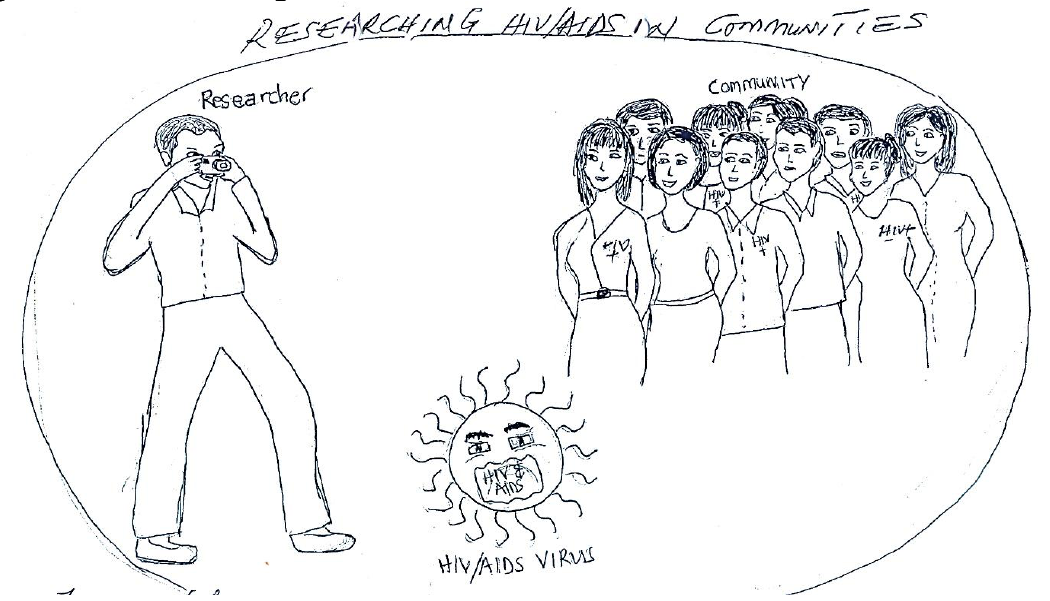
Figure 4: ‘Researching HIV/AIDS in